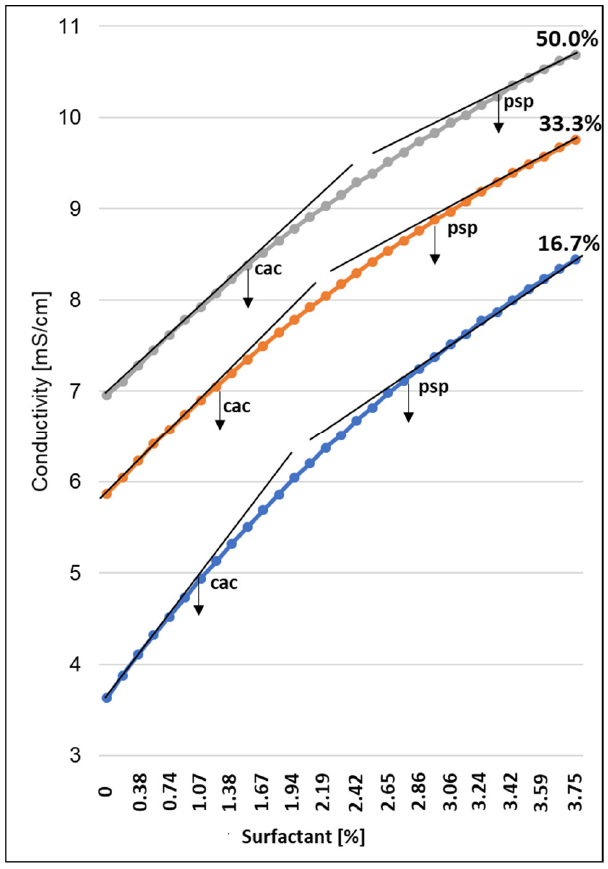
Figure 6. Plots of conductivity versus sodium coco sulfate concentration for various concentrations of Bacillus -fermented supernatant.